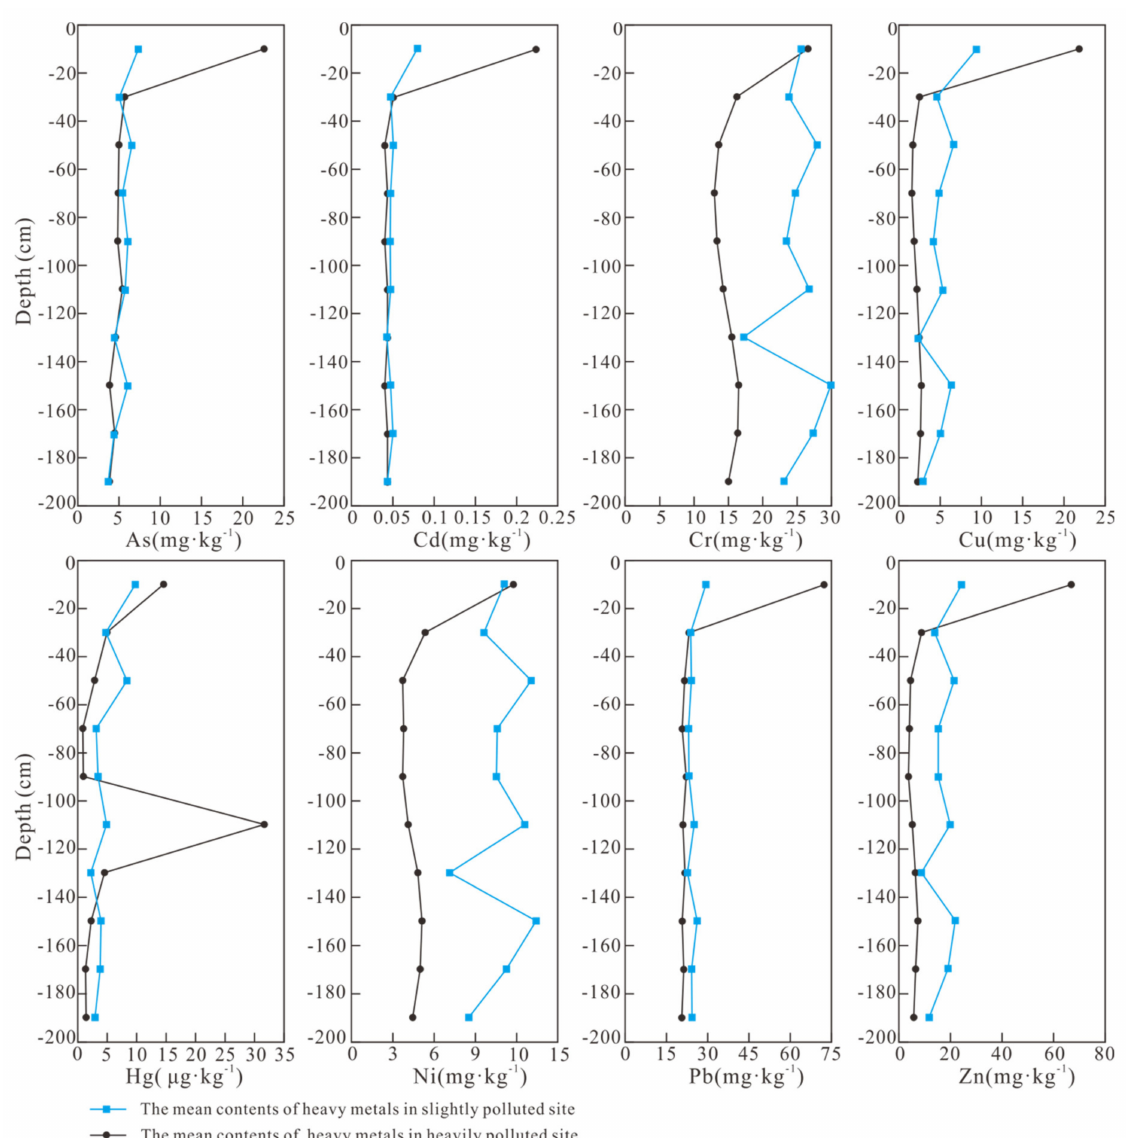
Figure 4. Vertical distribution plots of heavy mental in slightly and heavily polluted